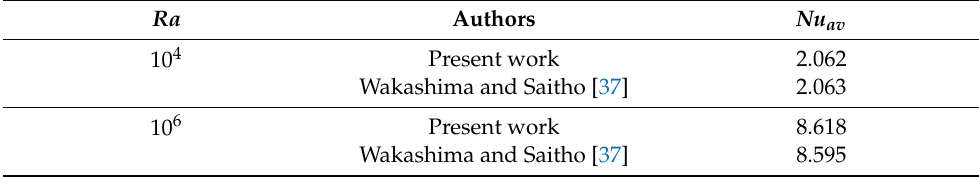
Table 1. Verification of the present model with the findings of Wakashima and Saitho